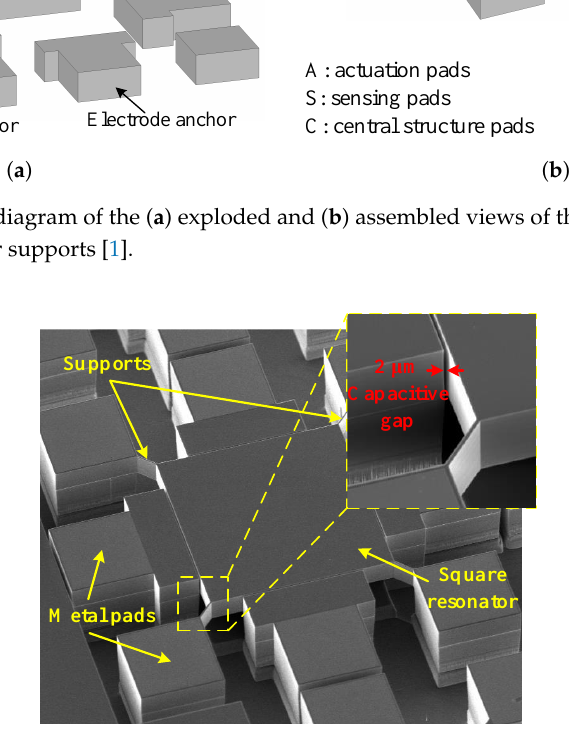
Figure 2. SEM micrograph of the Lamé-mode MEMS resonator with corner supports